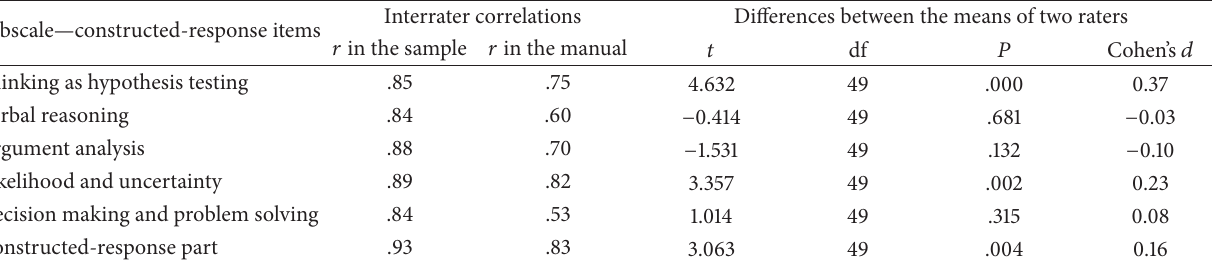
Table 5: Interrater correlations and differences between the means between two raters on the constructed-response subscales of the HCTA.